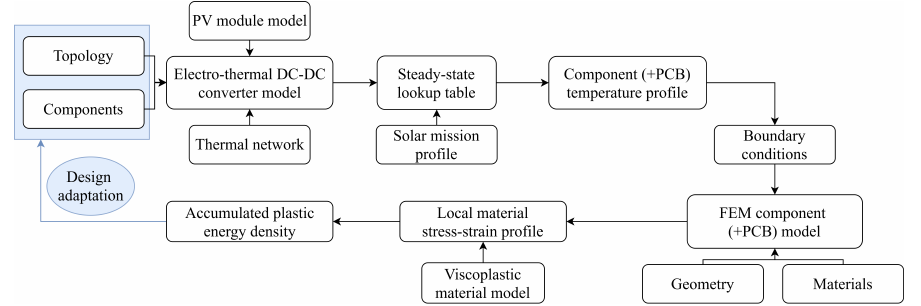
Figure 1. The Design for Reliability methodology applied to photovoltaic DC/DC converters [17].